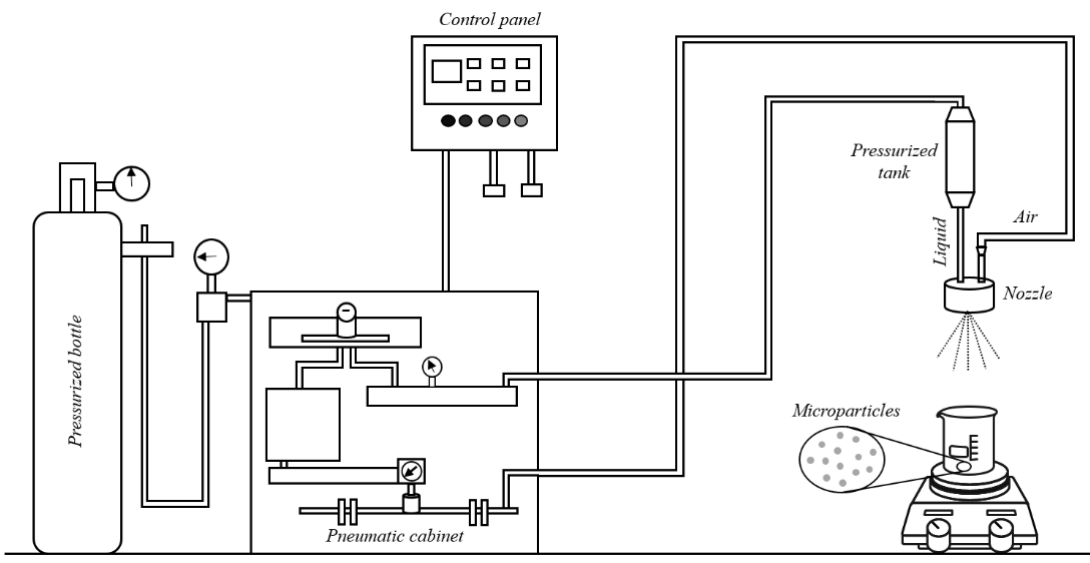
Figure 1. Experimental device to generate microparticles (Adapted from Herrero et al. [8]). After that, air and liquid pressures were adjusted by taking into account that air pressure must be equal or less than liquid pressure. Due to the pressure effect, the alginate solution flows from the tank through a nozzle (inner diameter: 250 µ m and outer diameter: 350 µ m). On the other part of the nozzle, air is introduced from an air cylinder in order to provide the required kinetic energy and the instabilities to disintegrate the liquid jet. The formed droplets are sprayed into a crystallizer with 140 mm diameter (Scharlab)